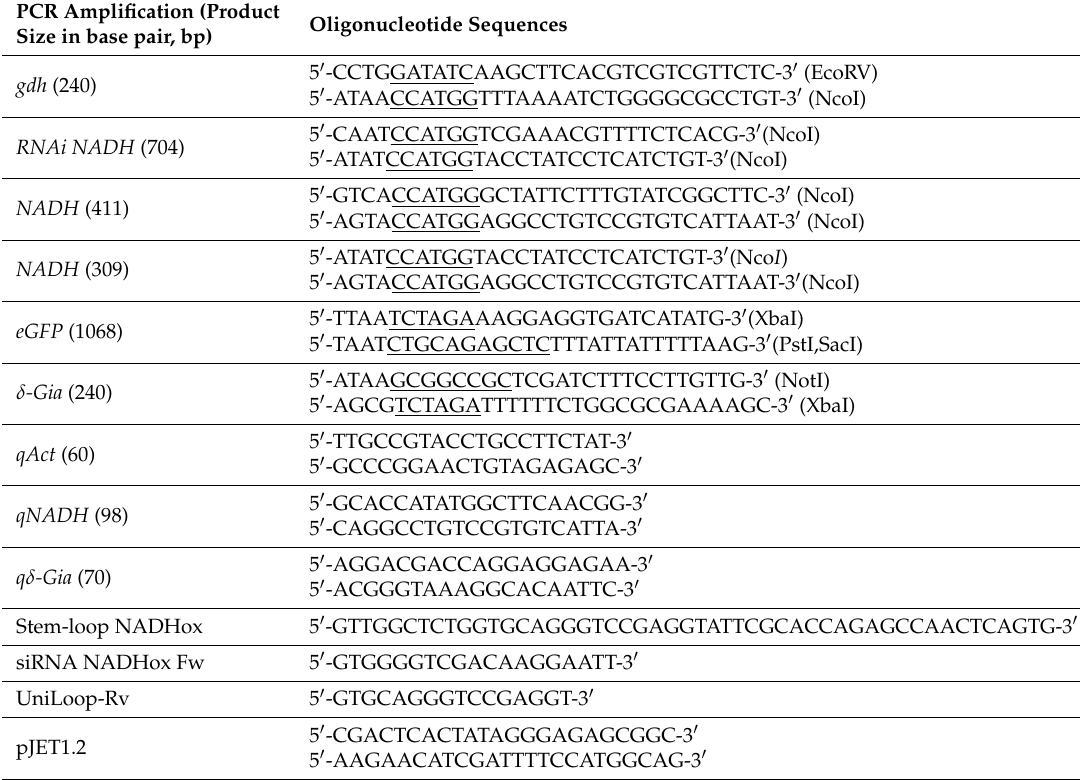
Table 1. PCR primers used in this work; the location of the restriction sites in the primer sequences is